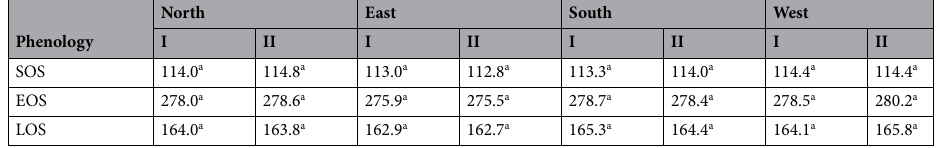
Table 4. latitude differences of RSP on different aspects. The same letters indicate that there is no significant difference between the different zones.